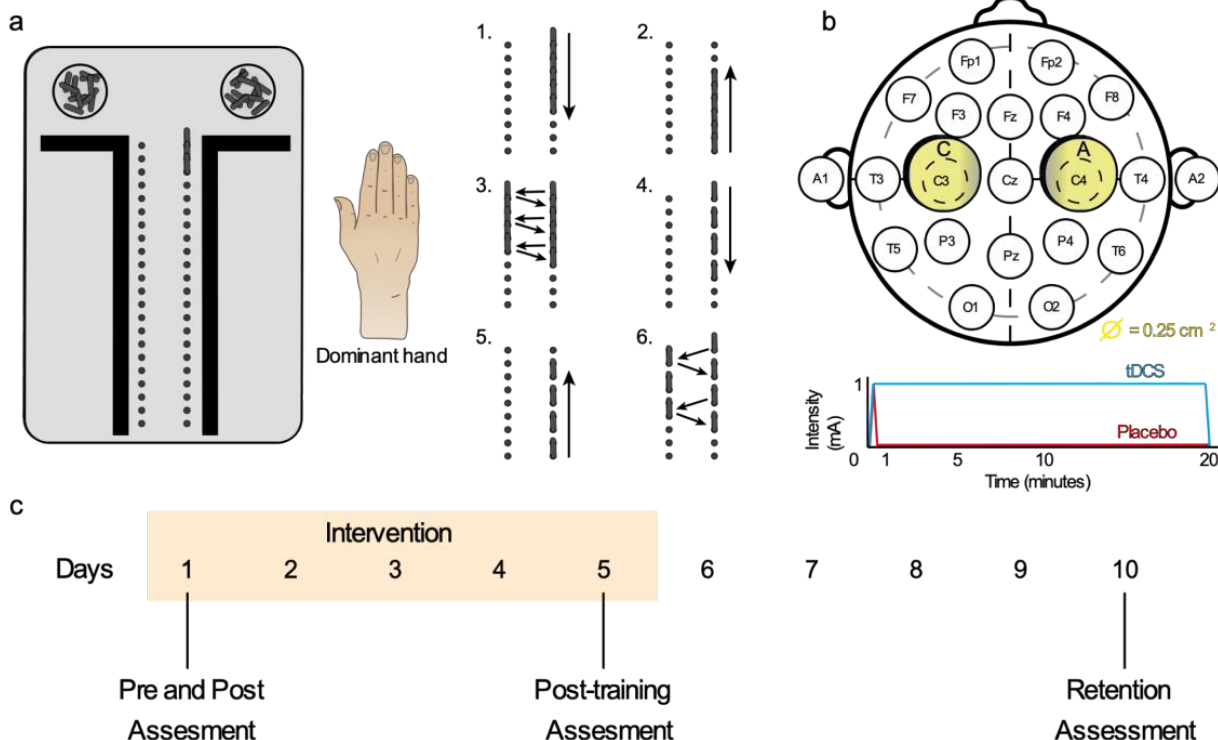
Figure 2. Intervention Methodology. The ( a ) six exercise program with PPT consisted of: 1, placing sticks in one of two vertical columns of holes, one by one, from top to bottom; 2, the same exercise from bottom to top; 3, filling both columns by placing sticks alternately from top to bottom; and 4–6 were exercises 1-3, respectively, but with a free hole left between sticks. After each exercise, participants removed the sticks in reverse order. The ( b ) reversal bi-hemispheric tDCS electrode positioning. We placed the anode on the right (C4) and the cathode on left (C3) primary motor cortex (M1). The ( c ) intervention was applied for five days and the participants’ assessment was performed in basal conditions (previous to any intervention), after the first intervention, after finishing the 5-day intervention, and after 5 days without intervention, to assess retention of motor skills.